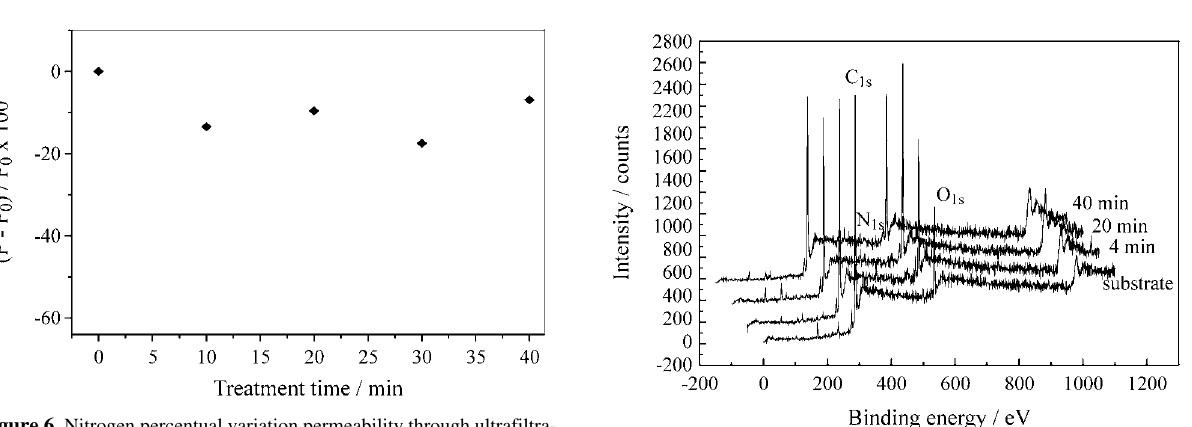
Figure 7. AFM top view images of the surface of the PSf modified by argon plasma, 15 W, 20 min. R a = 5.2 nm.